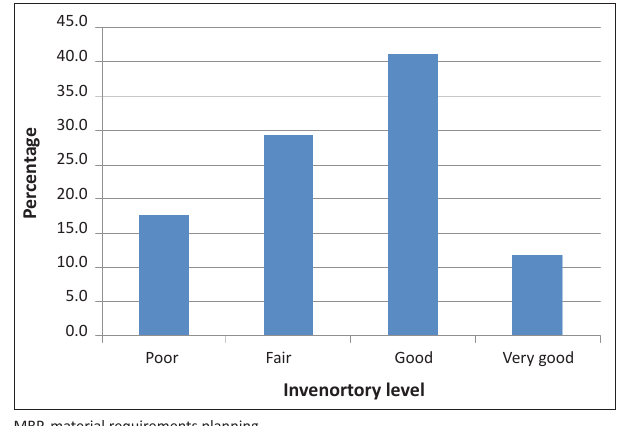
FIGURE 3: Rating of inventory levels.